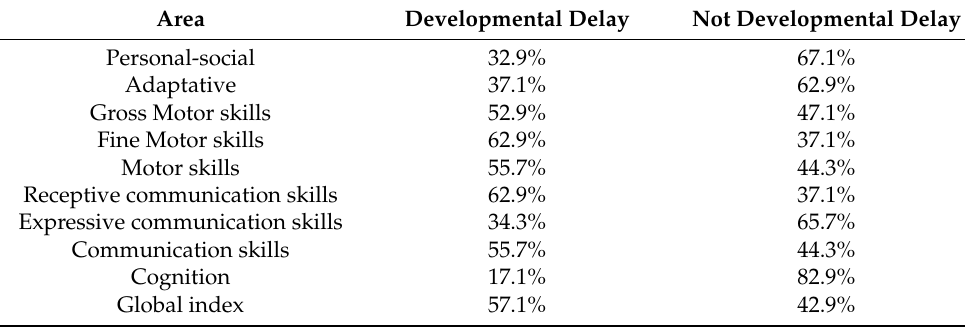
Table 4. Percentage of children with developmental delay in each of the